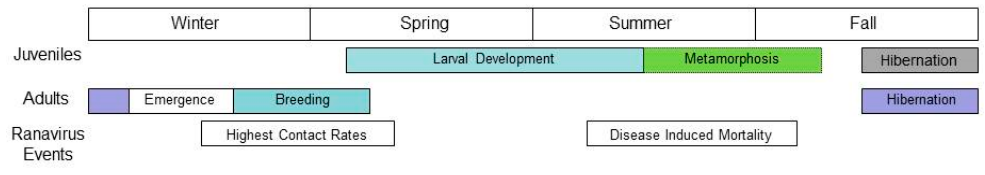
Figure 1. Annual cycle of important life history events for common frogs ( Rana temporaria ) and important events for ranavirus infections and diseases, for these animals. Boxes shaded in blue are those that occur in the aquatic environment, green boxes are those that straddle the land and water, grey boxes occur at an unknown location, and mauve boxes are life history events that are known to happen on both the land and in the water.